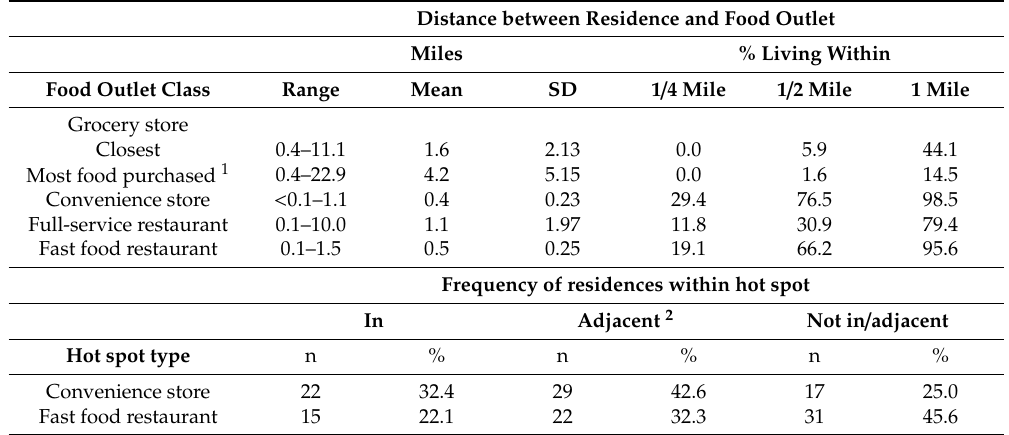
Table 2. Distances between Delta Healthy Sprouts participants’ residence and food outlets and frequencies of residences in food outlet hot spots.